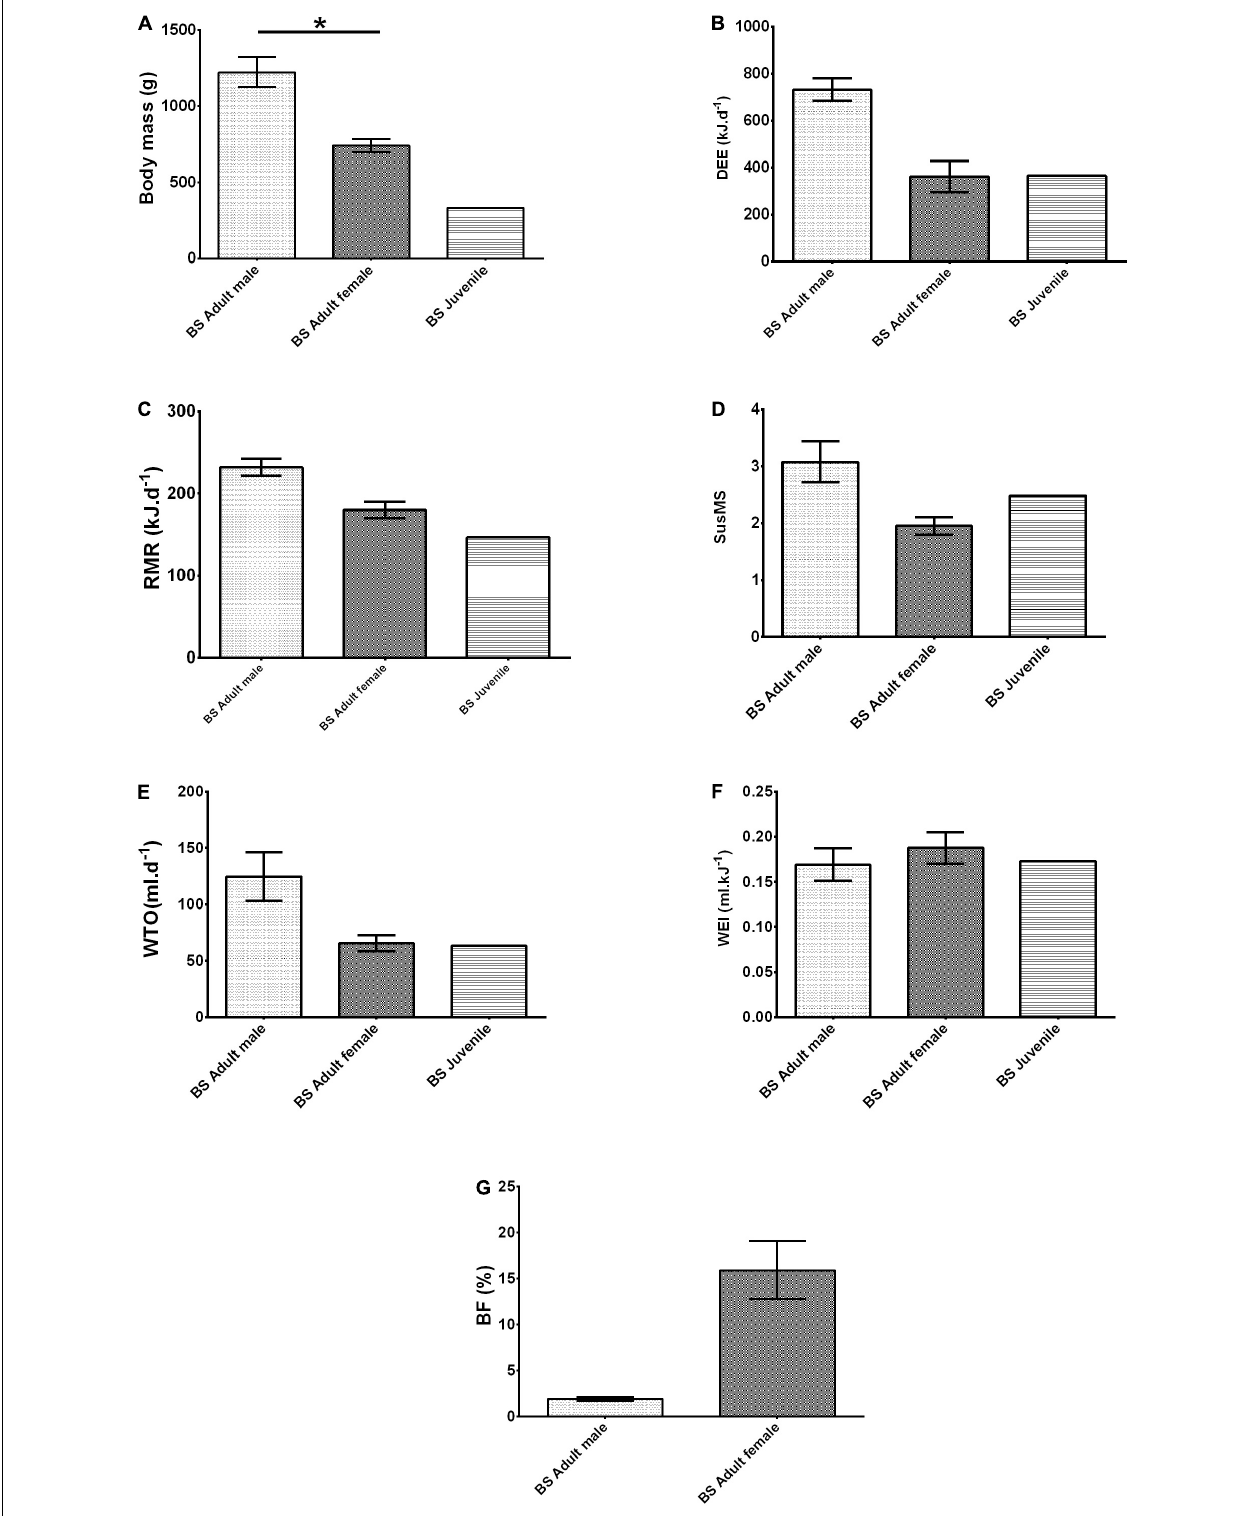
FIGURE 1 | (A) Body mass (g), (B) daily energy expenditure (DEE- kJ.d – 1 ), (C) resting metabolic rate (RMR- kJ.d – 1 ), (D) sustained metabolic scope (SusMS), (E) water turnover (WTO- ml.d – 1 ), (F) water economy index (WEI- ml.kJ – 1 ), and (G) body fat percent (BF-%) of adult (male and female) and juvenile Bathyergus suillus (BS). Data are shown as Adjusted mean (EMMs) ± SE. An asterisk indicates significance ( p ≤ 0.05).